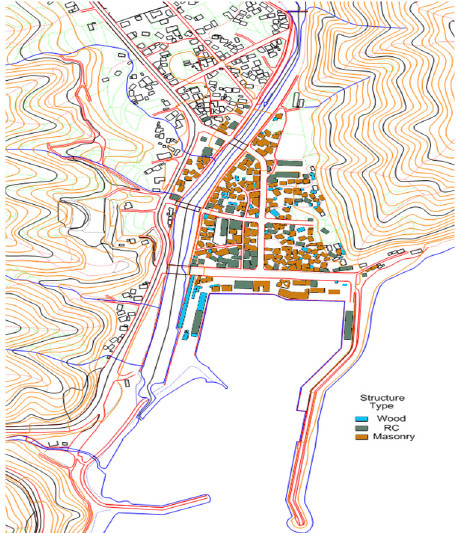
Figure 4. Building structural types in areas vulnerable to tsunami inundation.